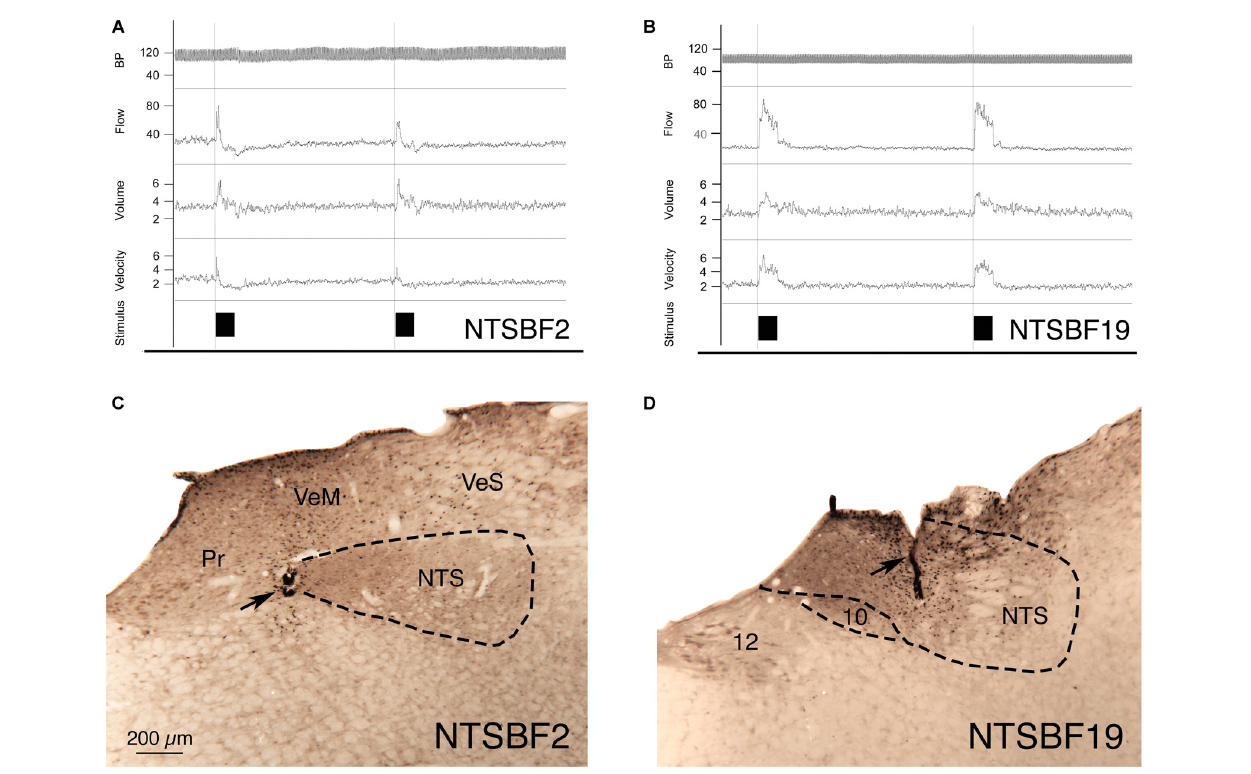
FIGURE 3 | Choroidal vasodilation with NTS stimulation from an illustrative case (NTSBF2) with 100 µ A anodal stimulation (A,C), and an illustrative case (NTSBF19) with 20 µ A cathodal stimulation (B,D). (A) Shows recording traces for arterial blood pressure (ABP), ChBF, volume and velocity in response